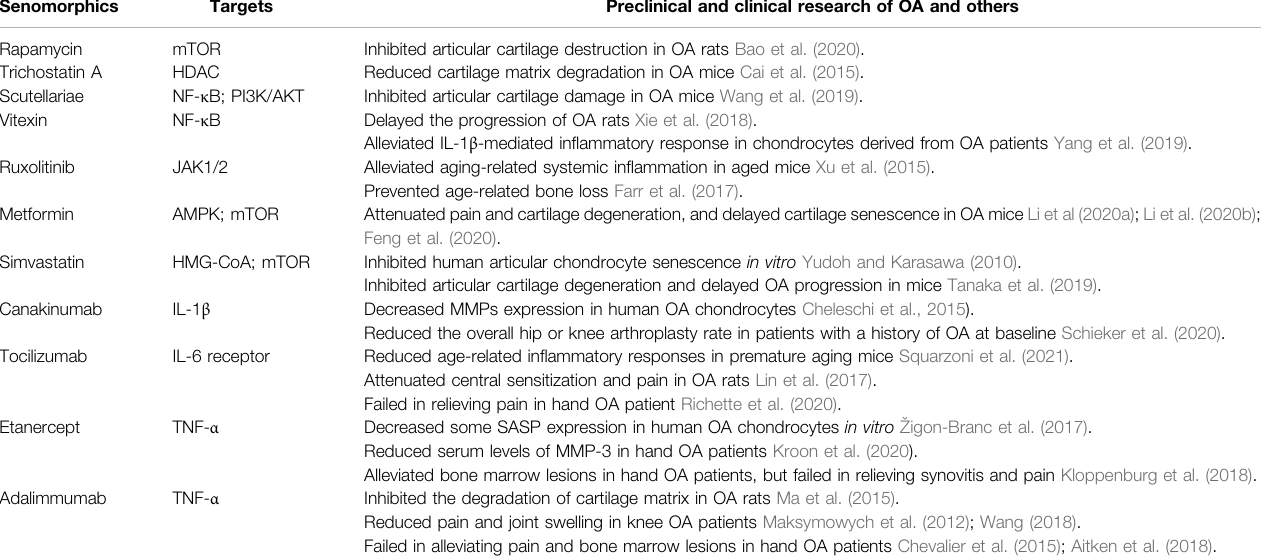
TABLE 3 | Senomorphics on anti-aging therapy. Senomorphics Preclinical and clinical research of OA and